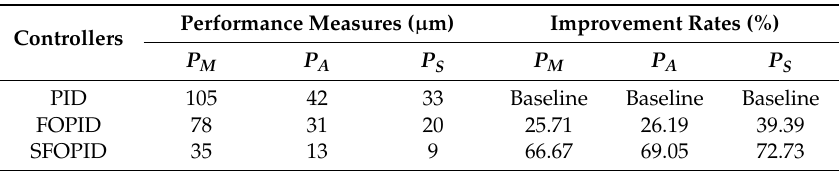
Table 1. Performance measures and improvement rates for the sinusoidal reference tracking of various VCM control systems in Case